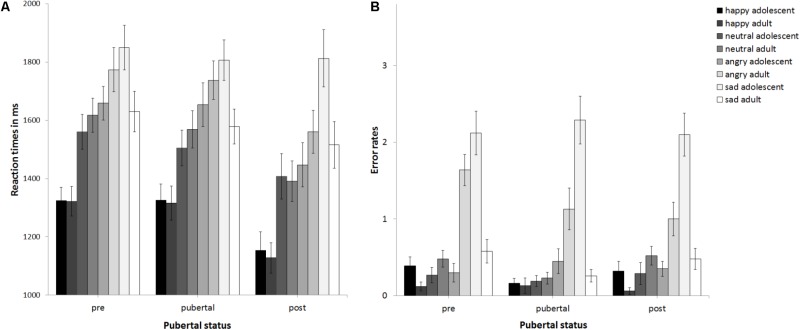
Mean reaction times (A) and error rates (B) as a function of pubertal status. Error bars indicate standard error of the mean (SEM).